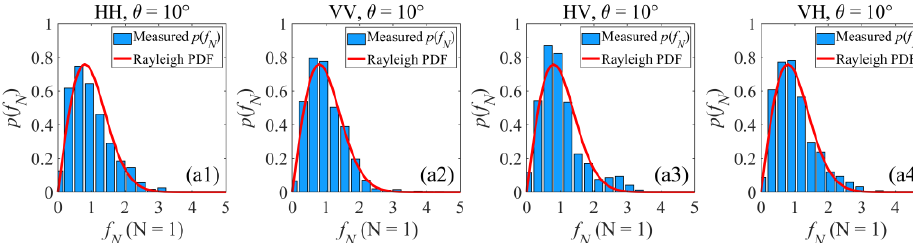
Figure 8. Theoretical PDFs and CDFs of the Rayleigh fading model as a function of independent samples, N for ( a ) linear detection and ( b ) square-law detection.